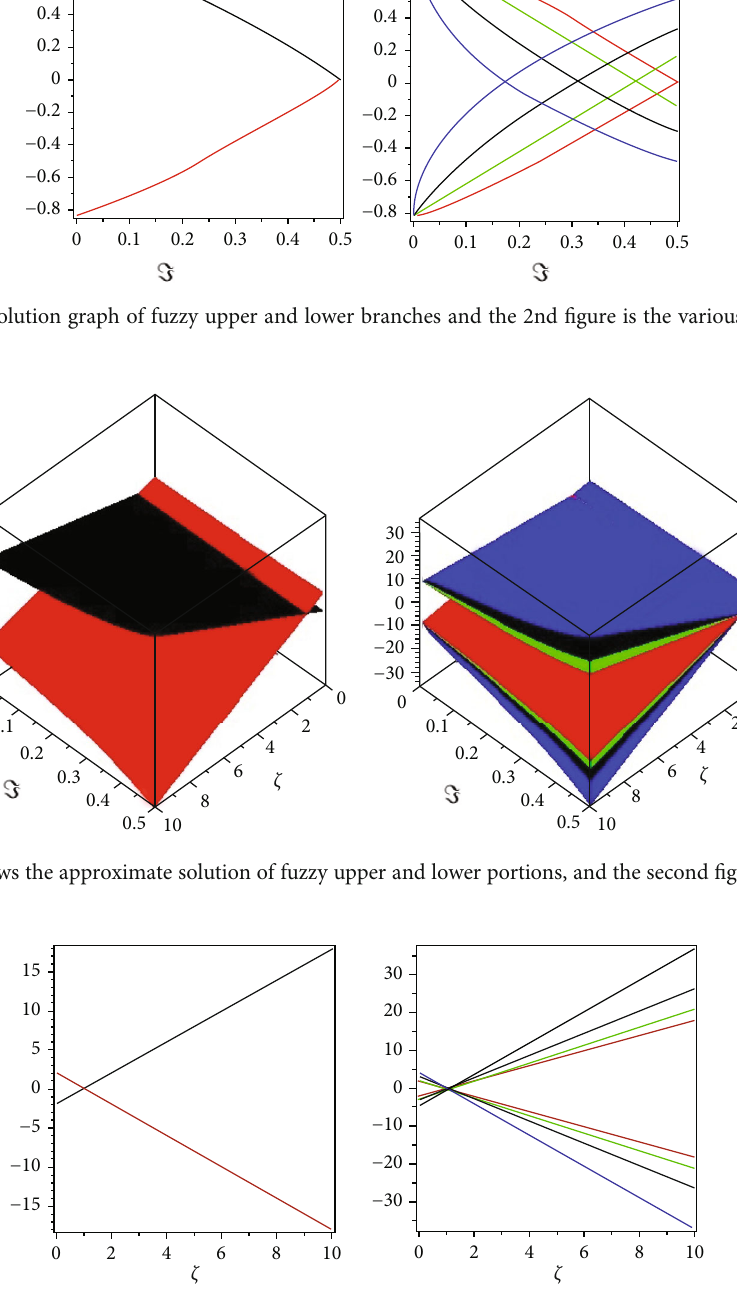
Figure 7: The approximate solution graph of fuzzy upper and lower branches and the 2nd fi gure is the various fractional order of ℘ .